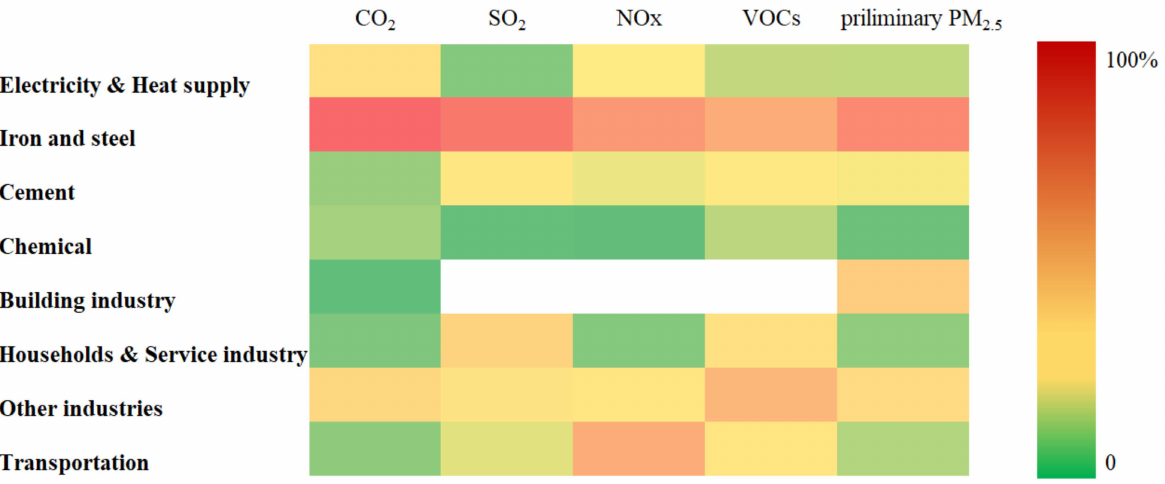
Figure 3. The sectoral contribution of CO 2 and air pollutant emissions of Tangshan in